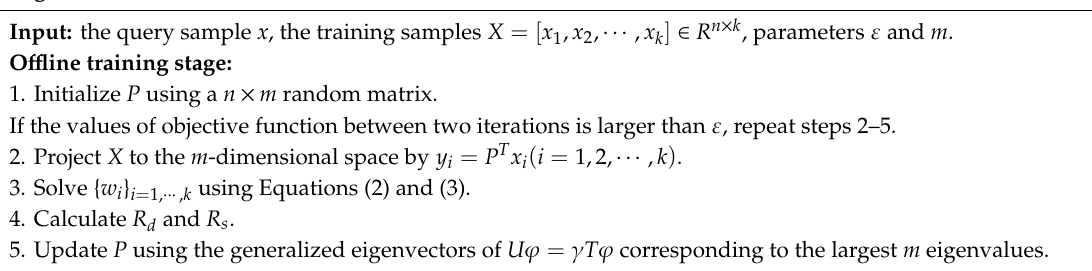
Algorithm 1. CRC-DP